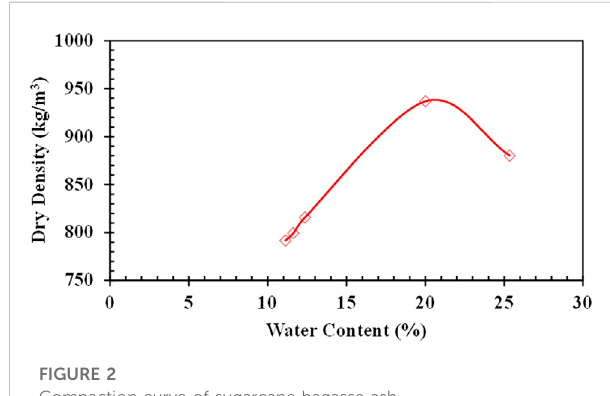
FIGURE 2 Compaction curve of sugarcane bagasse